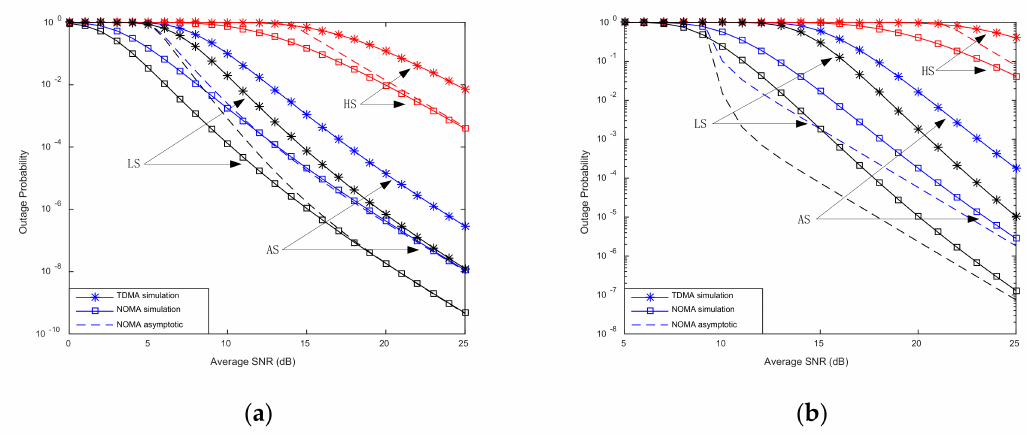
Figure 2. Outage probability vs. signal-to-noise ratio (SNR) for fading conditions. ( a ) User 1; ( b ) User 2.